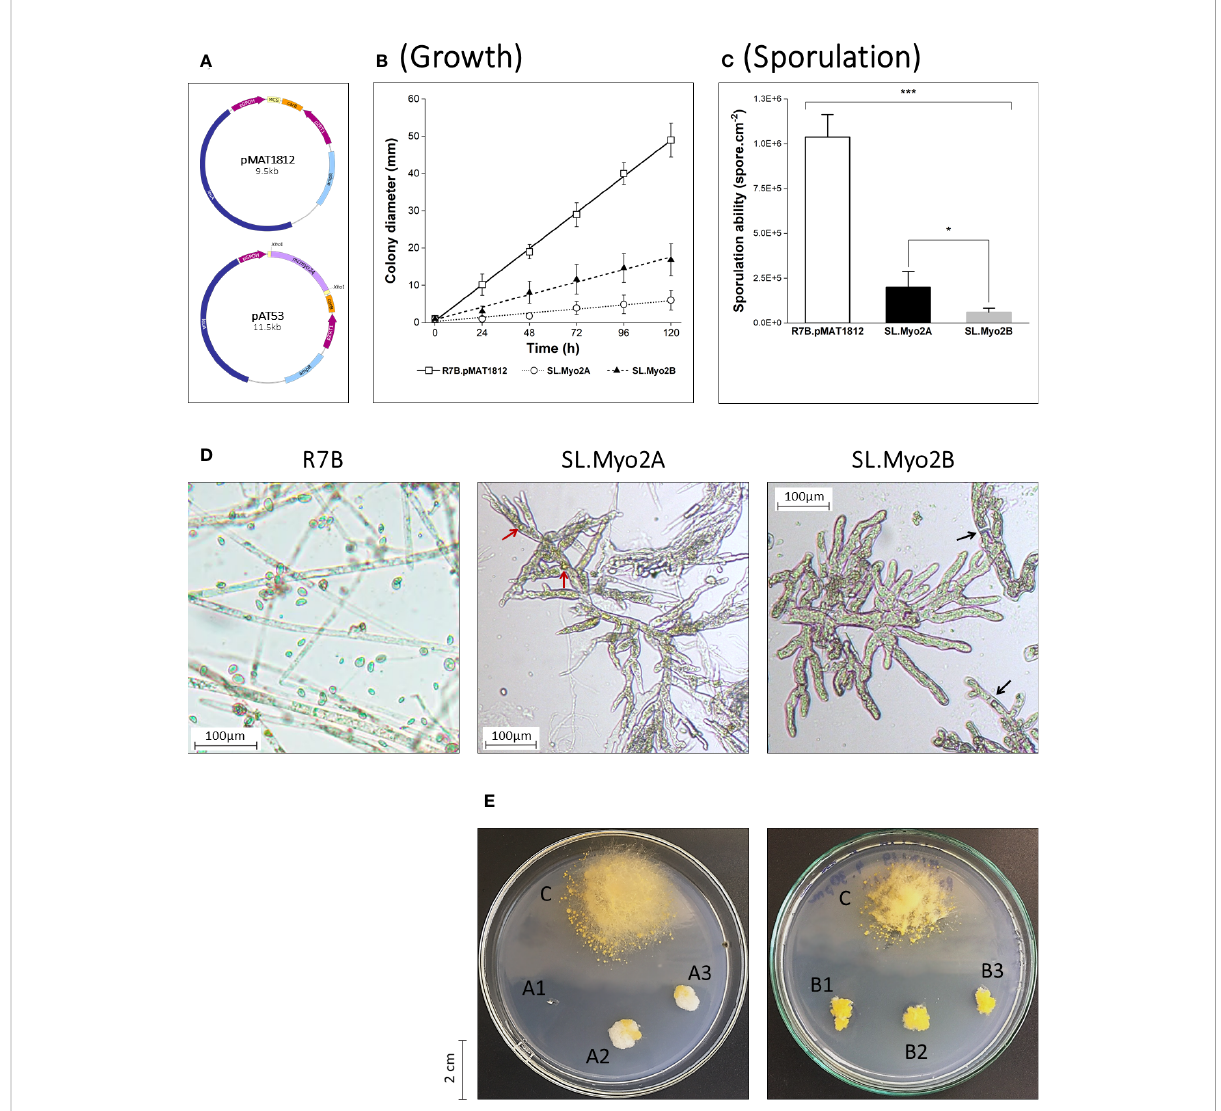
FIGURE 1 Initial functional screening of myosin II motors in Mucor circinelloides via RNA interference. (A) Schematic illustration of vector pMAT1812 and the RNAi plasmid pAT53 corresponding to the mcmyo2A gene. Quanti fi cation of growth rate (B) and vegetative sporulation (C) of myosin II silencing phenotypes (*p<0.05, ***p<0.001). Small pieces of grown mycelia of each strain were grown in YNB medium plates (pH 2.8) at 26°C under a continuous light condition for 120 hours in the growth rate measurements. In the case of sporulation assessment, the inoculated fungi were incubated for 72 hours to collect the total vegetative spores. (D) Microscopic images display morphological abnormalities of myosin II silencing phenotypes, compared to the wild-type (WT) R7B. Red arrows denote pigment- fi lled vesicles; black arrows denote septa in fungal hyphae. Some elongated WT-like hyphae can be observed in SL.Myo2A (background) due to the decrease of silencing effect through generations in the silencing mutant. (E) Colonies of SL.Myo2A (A1 – 3) and SL.Myo2B (B1 – 3), compared to the control R7B.pMAT1812 strain (C) at 72 h of incubation. Colonies were grown on YNB media (pH 2.8) at 26°C under a continuous light